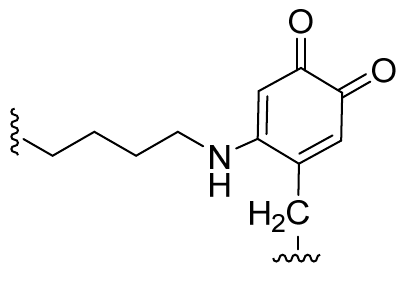
Figure 3. Lysine tyrosylquinone